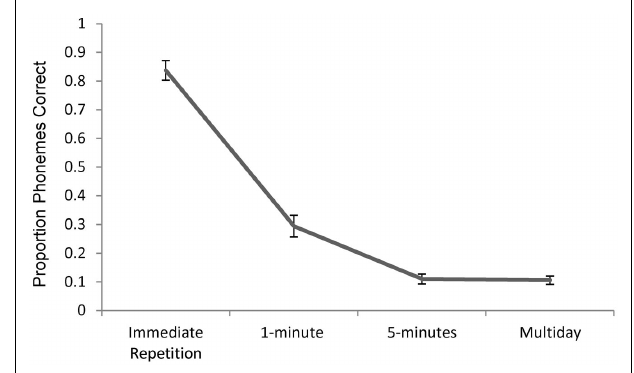
FIGURE 4 | Mean proportion phonemes correct for uncued production attempts across time intervals.